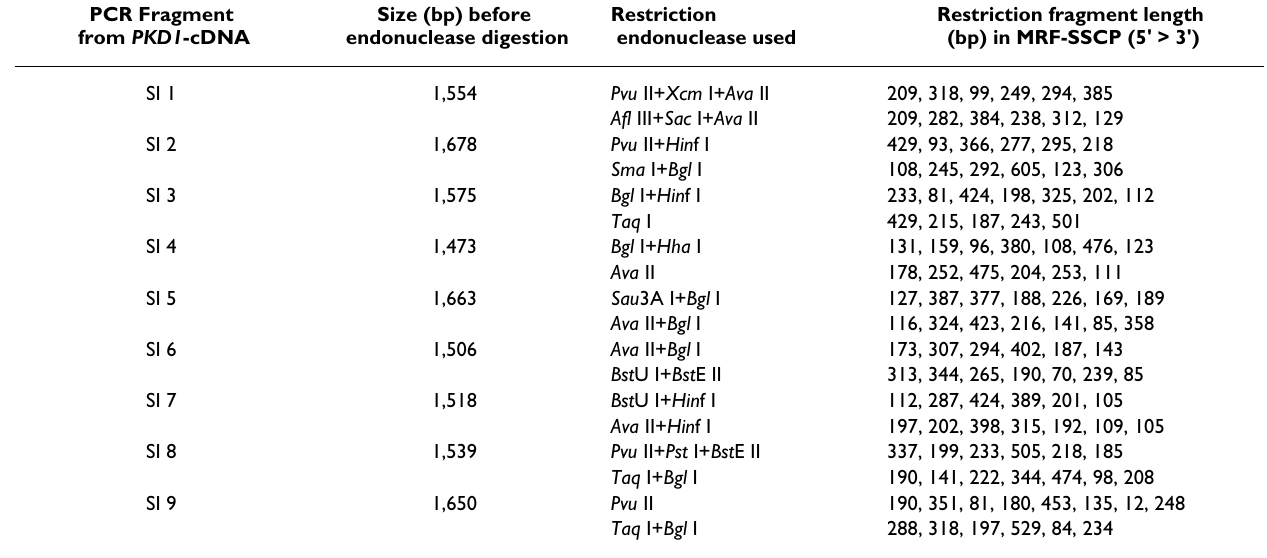
Table 2: MRF-SSCP for mutation analysis of the full-length PKD1 cDNA PCR Fragment from PKD1 -cDNA